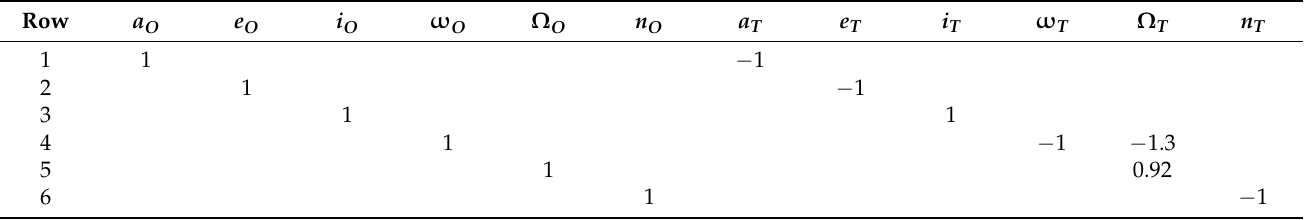
Table 5. The reduced row echelon in symmetric